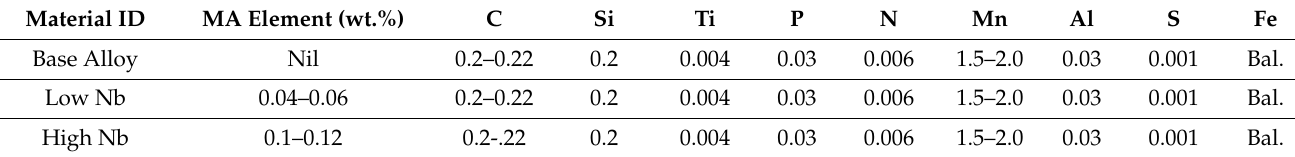
Table 1. Chemical compositions of microalloyed steels